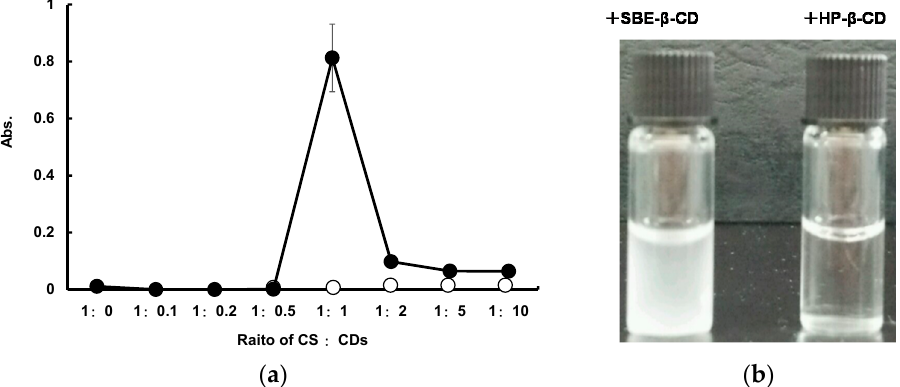
Figure 1. Effect of the weight ratio of spray-dried chitosan (SD-CS) and sulfobutyl ether- β -cyclodextrin (SBE- β -CD) (close circles) or HP- β -CD (open circles) on the absorbance as a measurements of turbidity of the solution ( a ) and appearance of SD-CS/SBE- β -CD solution (left) and SD-CS/HP- β -CD solution (right) (weight ratio = 1:1) ( b ).